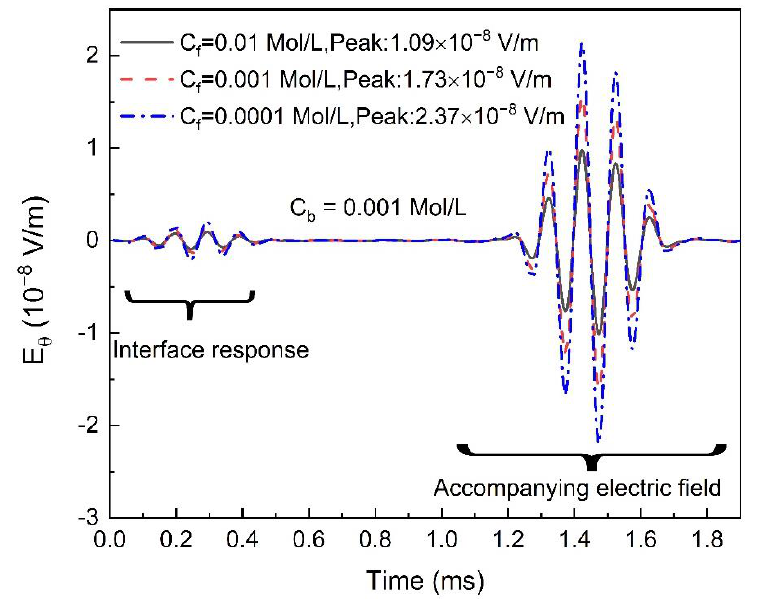
Figure 3. Electric fields for different levels of 𝐶 𝑓 . The solid line, dashed line and dot-dashed line correspond to the salinity level 𝐶 𝑓 = 0.01,0.001,0.0001 Mol/L respectively.